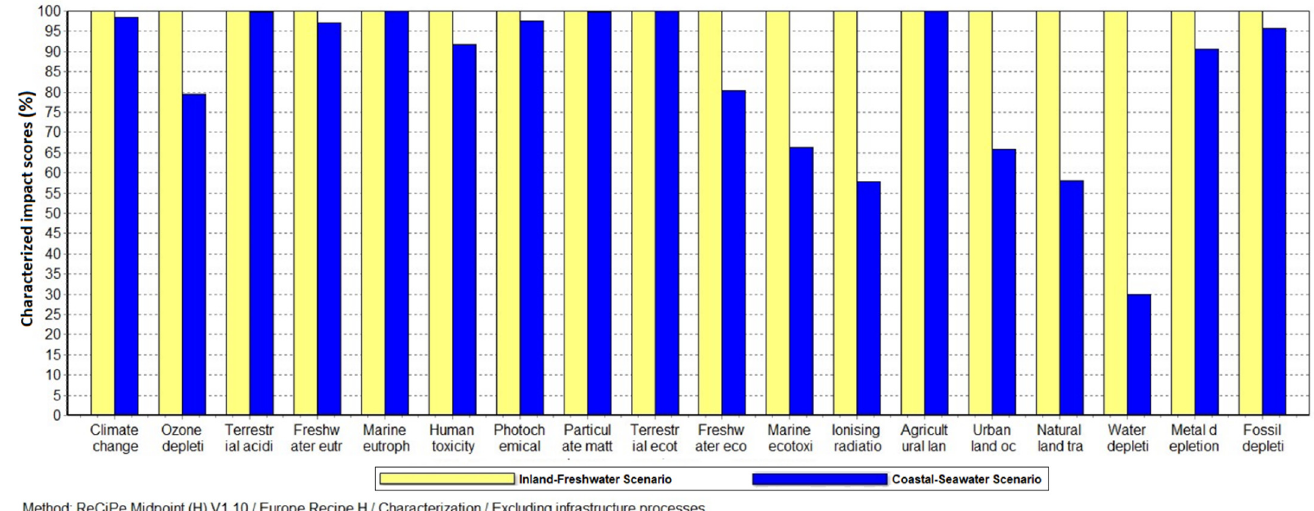
Figure 6. Complete impact assessment results for beet washing only in each scenario. The graph is characterized for direct comparison in 18 impact categories. Table 5. Complete life cycle environmental impacts of the two scenarios of bioethanol production for the beet washing step only.